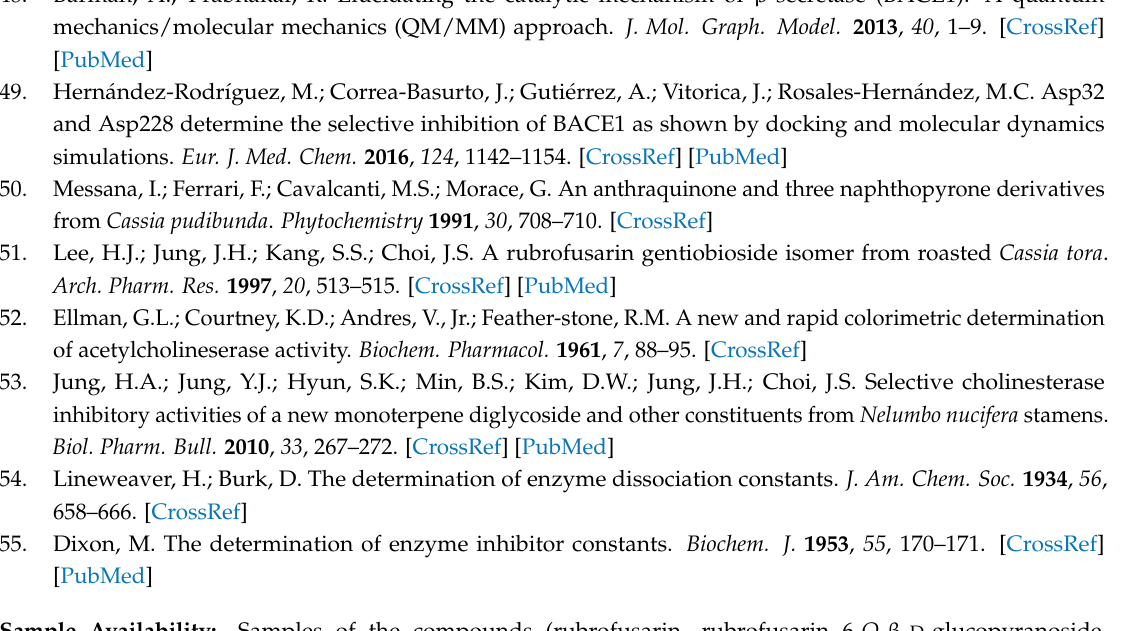
Sample Availability: Samples of the compounds (rubrofusarin, rubrofusarin 6- O- β - D -glucopyranoside, rubrofusarin 6- O- β - D -gentiobioside, nor-rubrofusarin 6- O- β - D -glucoside, isorubrofusarin 10- O- β - D -gentiobioside, and rubrofusarin 6- O- β - D -triglucoside) are available from the